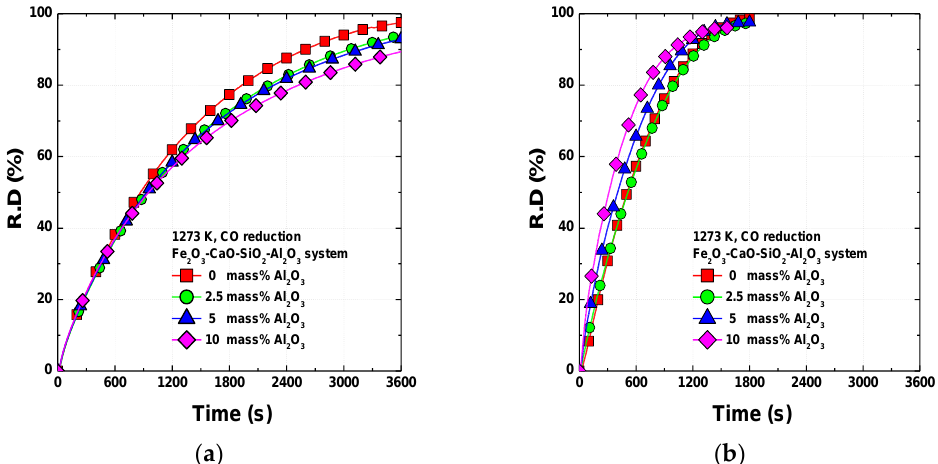
Figure 3. Reduction behavior of sinter with various Al 2 O 3 contents at 1273 K under CO gas: ( a ) equilibrium samples, ( b ) metastable samples.